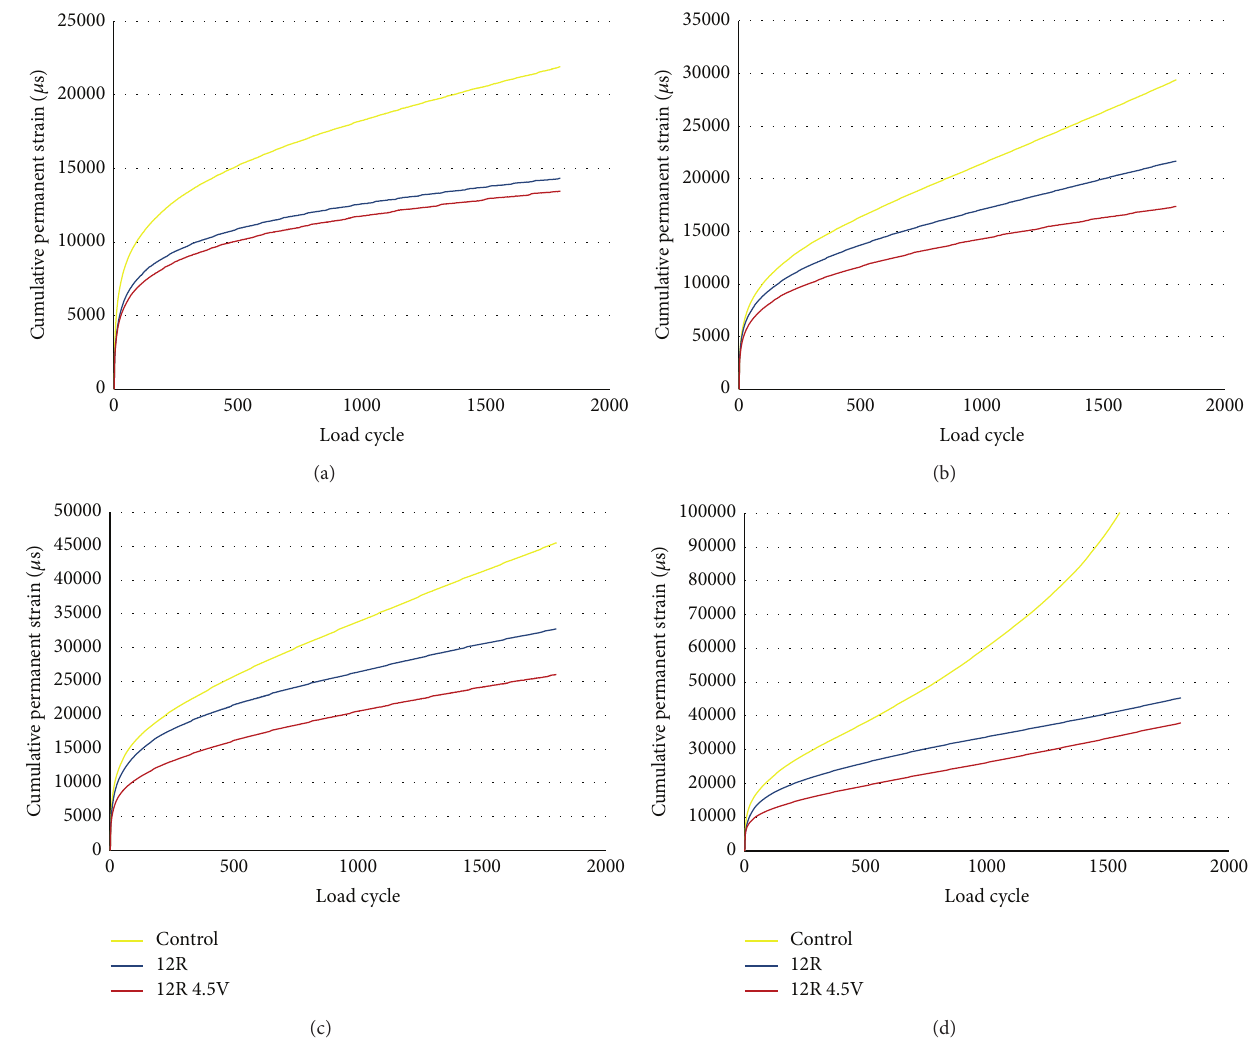
Figure 3: Cumulative permanent strain versus load cycle for control and rubberized mixtures tested at (a) 200 kPa at 40 ∘ C, (b) 200 kPa at 50 ∘ C, (c) 400 kPa at 40 ∘ C, and (d) 400 kPa at 50 ∘